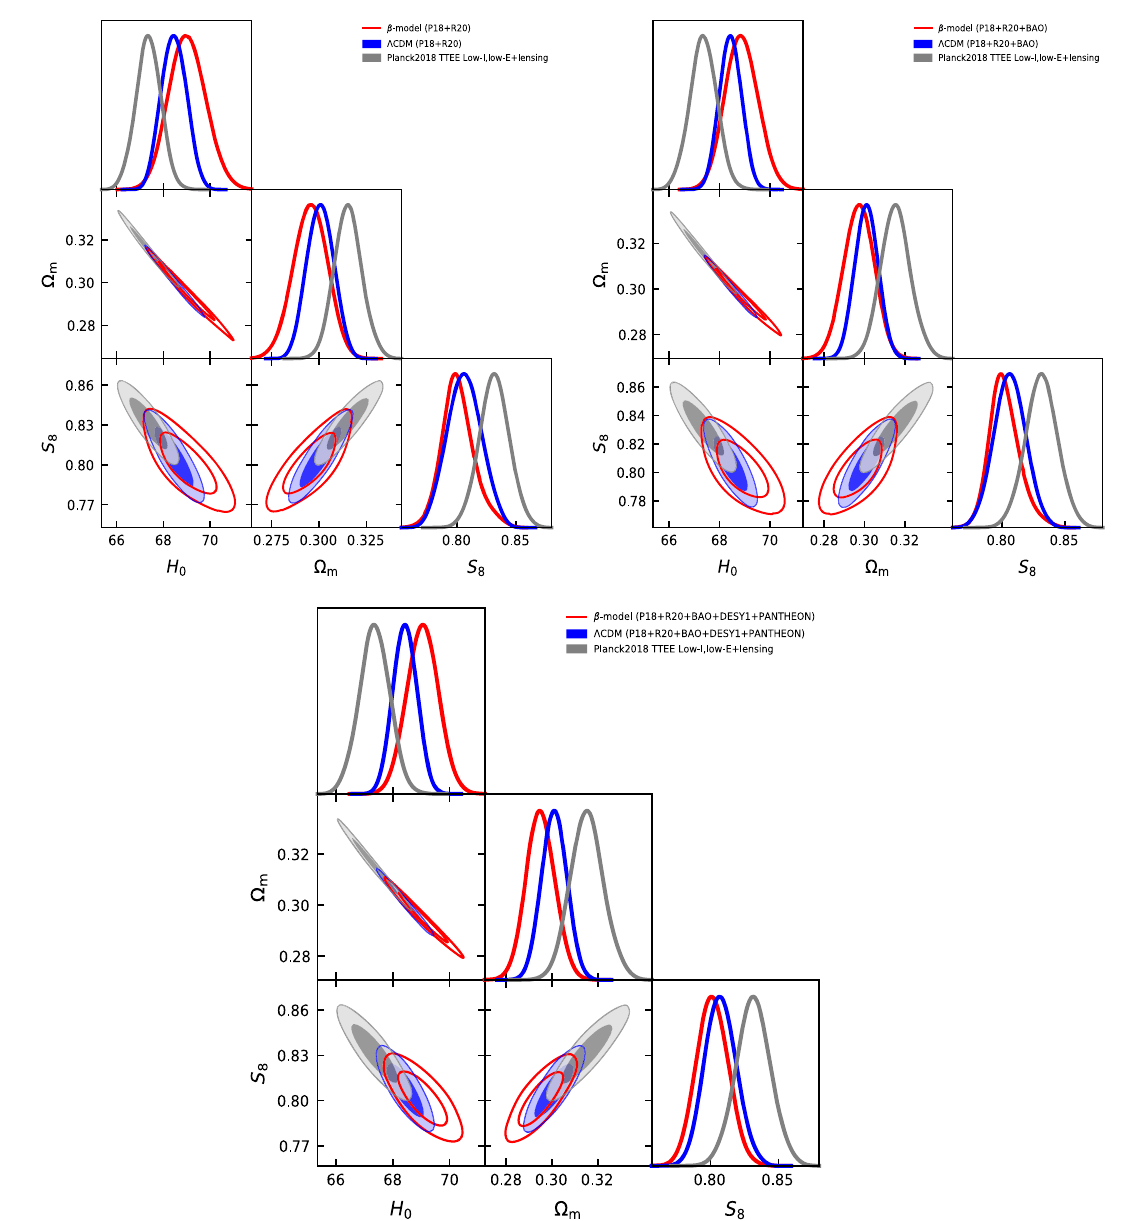
Fig. 2 The one-dimensional marginalised posterior distributions and two-dimensional contour plots with 68 . 4% and 95 . 7% C.L. of cos- mological parameters ( Ω m , S 8 , H 0 ). Red and Blue colours indicate the β -model and Λ CDM, respectively. The grey colour indicates the